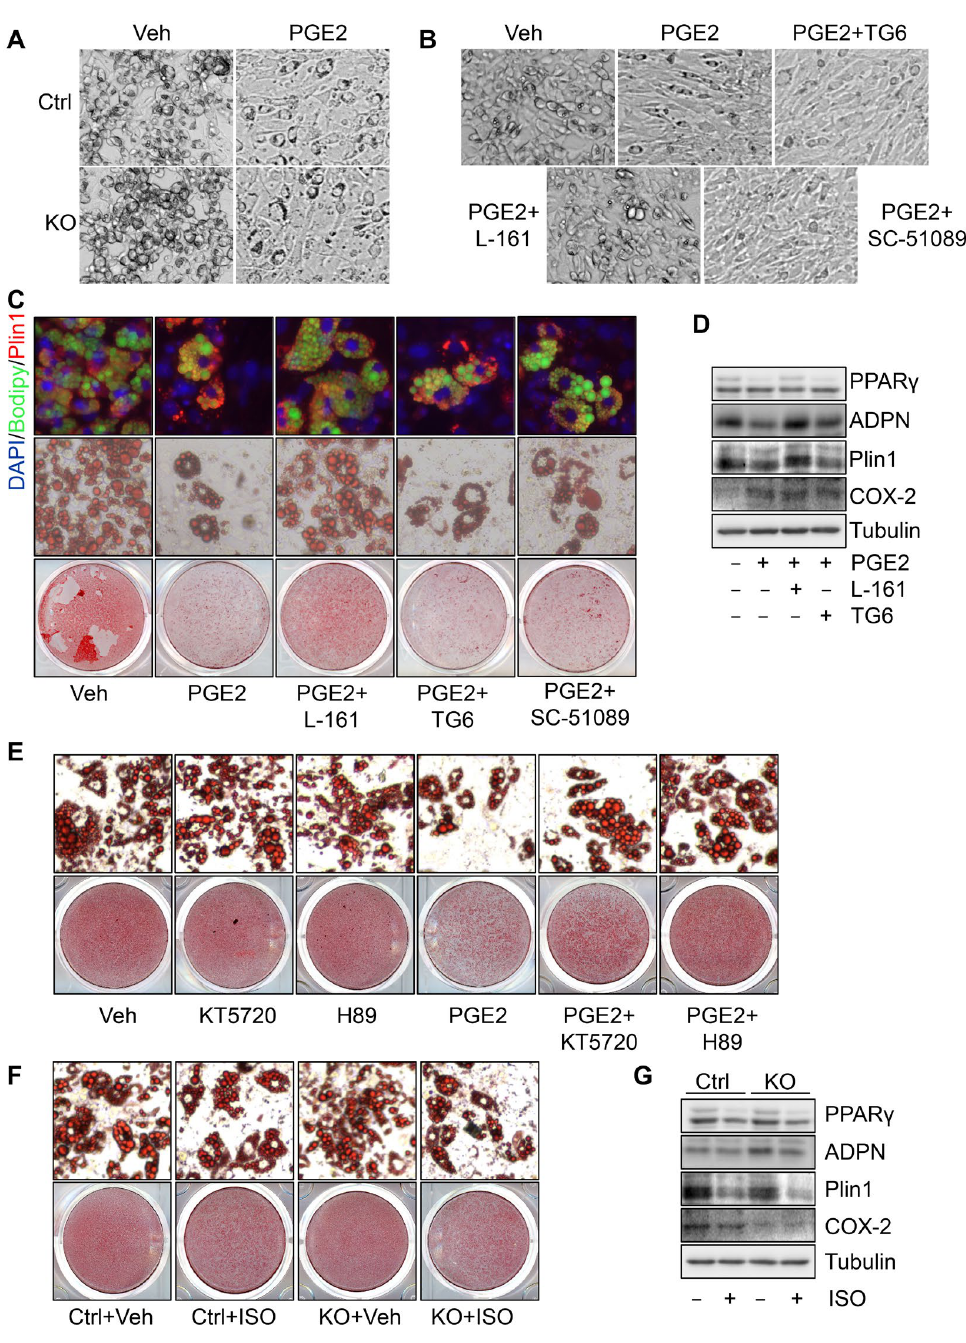
Figure 4. PGE2 suppresses PPAR γ expression and adipogenesis through PKA signaling. ( A ). The treatment of PGE2 blocked the morphology alteration at the early stage of differentiation. Starting from differentiation, primary preadipocytes were treated with 1 µ M PGE2, and the bright field images were taken on day two of differentiation. The suppressing effect of PGE2 on the white adipogenesis was restored by the treatment of PGE2 receptor EP4 antagonist L161,982 but not the antagonists of EP1 and EP2, SC-51089 and TG6-10-1 respectively, indicated by the bright field images of day two cells in differentiation ( B ), Oil red O/fluorescence staining ( C ), and expression levels of adipogenic markers PPAR γ , adiponectin, and Plin1 ( D ). ( E ). Inhibition of PKA with its specific inhibitors KT5720 or H89 restored the suppressing effect of PGE2 on adipogenesis. Activation of PKA with isoproterenol suppressed COX-2 deficiency-induced white adipogenesis presented by Oil red O staining ( F ) and expression of PPARγ, adiponectin , and Plin1 ( G ). Figure 4A–G is the representative data from three independent experiments.